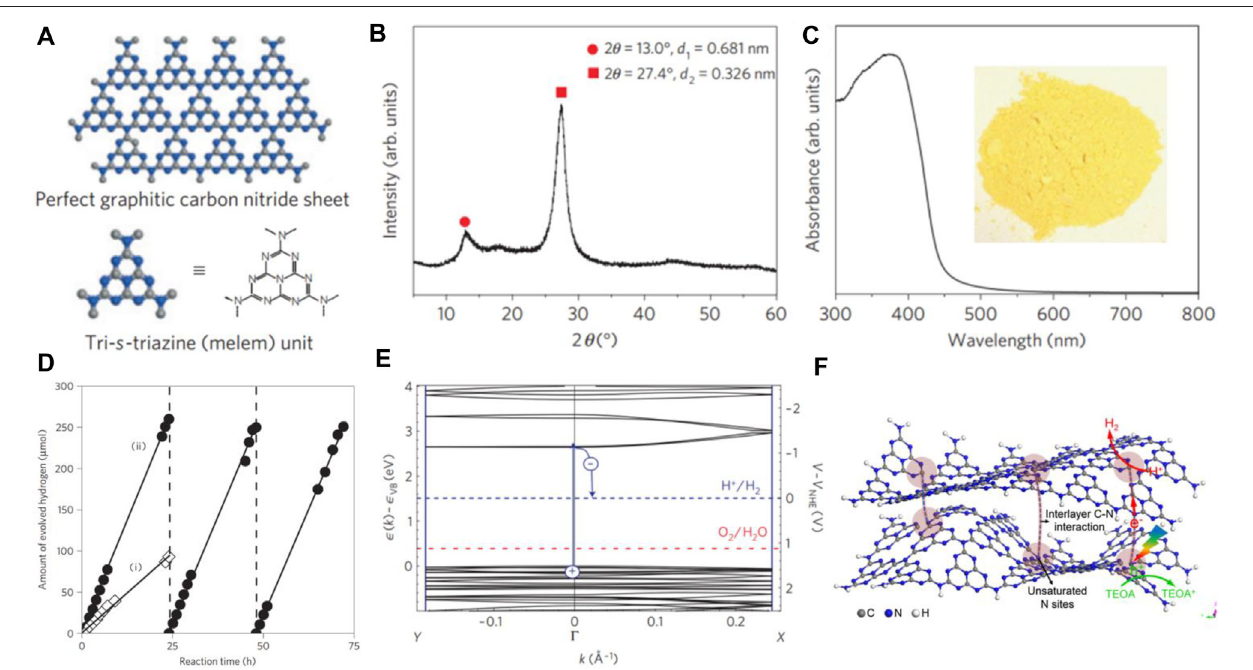
FIGURE1|(A) Schematicdiagramofaperfect g-C 3 N 4 sheetconstructed frommelem units, (B) experimentalXRDpattern ofg-C 3 N 4 , (C) ultraviolet – visiblediffuse re fl ectancespectrum oftheg-C 3 N 4 .Inset:Photographofg-C 3 N 4 , (D) typical timecourse ofH 2 production fromwatercontaining10vol%triethanolamineasanelectron donor under visible light (of wavelength longer than 420 nm) by (i) unmodi fi ed g-C 3 N 4 and (ii) 3.0 wt% Pt-deposited g-C 3 N 4 photocatalyst, (E) density-functional-theory band structure for polymeric melon calculated along with the chain ( Γ – X direction) and perpendicular to the chain (Y – Γ direction). The position ofthe reduction level forH + toH 2 isindicatedbythedashedblueline,andtheoxidationpotentialofH 2 OtoO 2 isindicatedbythereddashedlinejustabovethevalenceband.Copyright2009, Springer Nature; (F) illustration of the charge transfer in g-C 3 N 4 nanosheets under visible light. Copyright 2017, Elsevier.